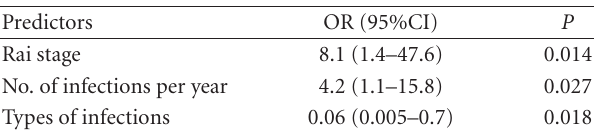
Table 4: Logistic regression analysis of factors predictive of GNR colonization in CLL